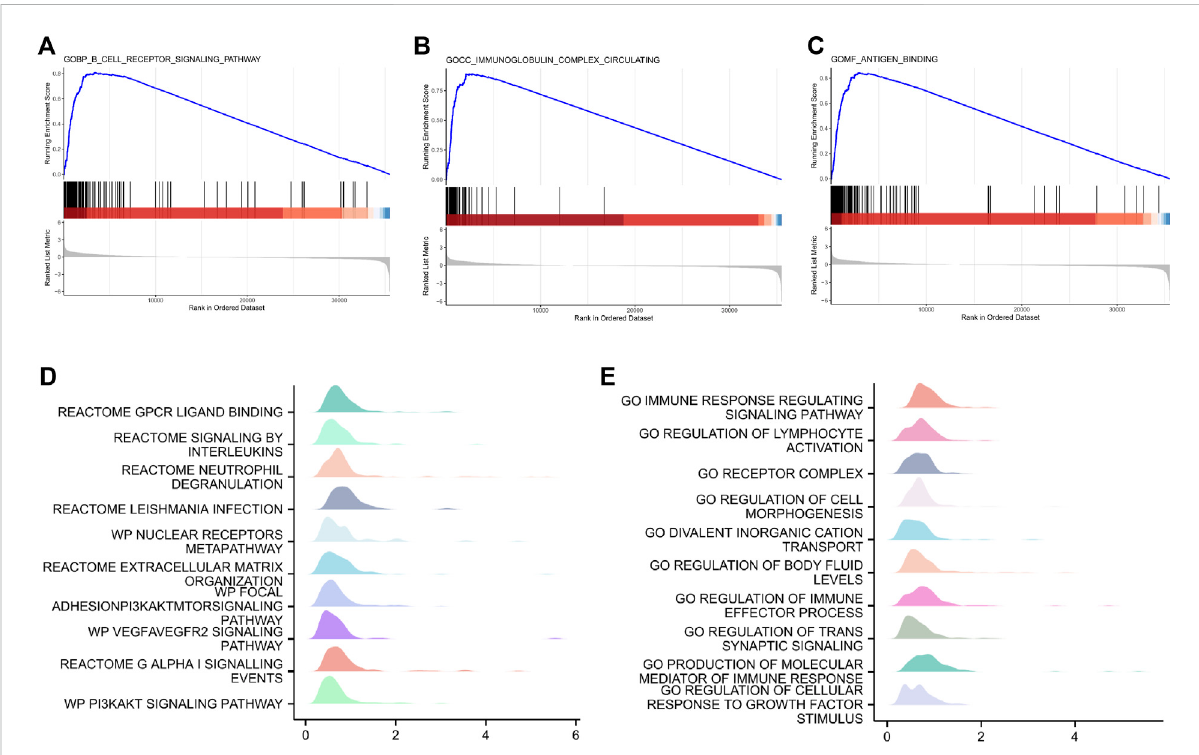
FIGURE 7 Gene set enrichment analysis showing the nine most important functions or pathways in low- and high-risk patients with gastric cancer in TCGA dataset. (A) GOBP: B-cell receptor signaling pathway. (B) GOCC:immunoglobulincomplex. (C) GOMF: antigen binding. (D,E) GSEA mountain plot of representative enrichments in C2. all and C5. all MSigDB datasets. Signi fi cance was set at p < 0.01. GOBP, Gene Ontology biological process; GOCC, Gene Ontology cellular component; GOMF, Gene Ontology molecular function; NES, normalized enrichment